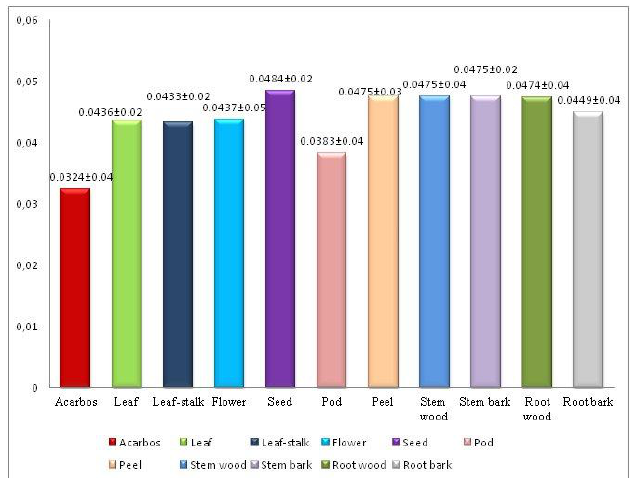
Figure 2: IC 50 (mg/mL) values from α-glucosidase inhibition of Calophyllum inophyllum Linn. Data were analyzed by non-linear regression analysis on MS Excel from the mean inhibitory data. IC 50 - Concentration of essential oil that scavenged 50% of acarbose.